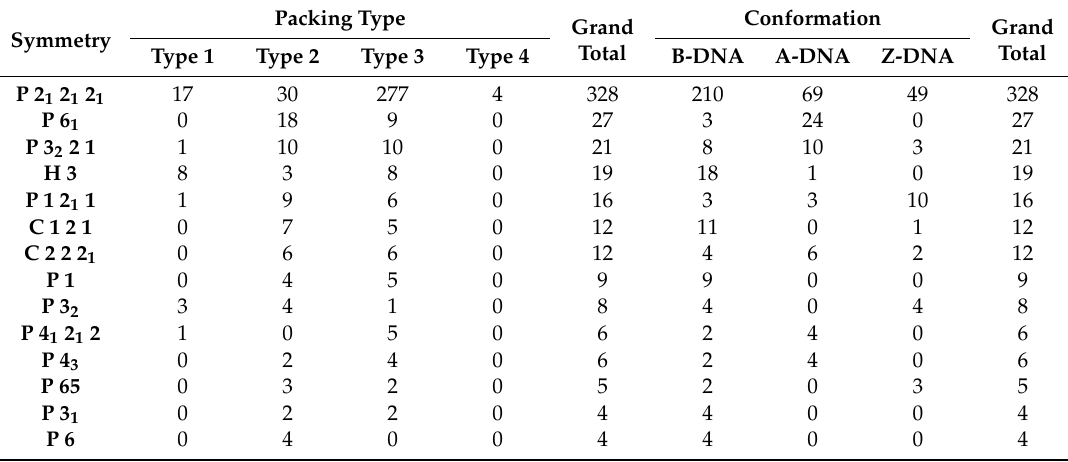
Table 5. Number of DNA structures belonging to di ff erent space groups, their packing types, and